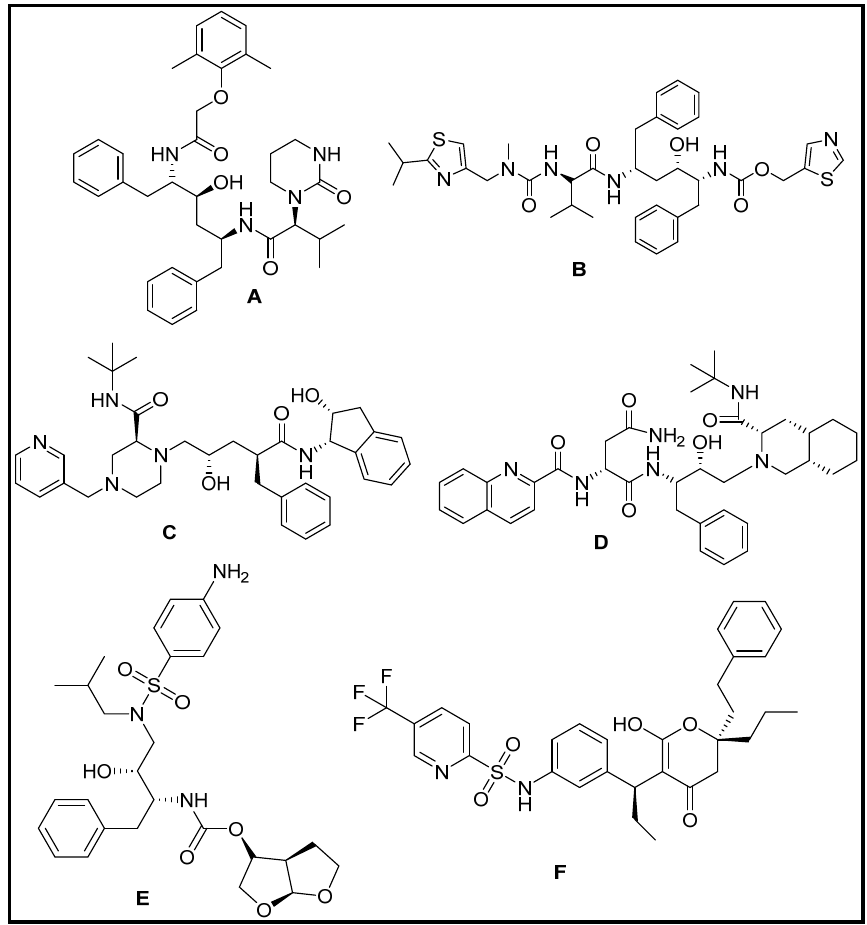
Figure 5. Chemical structures of six HIV protease inhibitors: ( A ) lopinavir; ( B ) ritonavir; ( C ) indinavir; ( D ) saquinavir; ( E ) darunavir; ( F ) tipranavir. A molecular dynamics study indicated three distinct domains for both 3CLpro-1 and 3CLpro-2 (Figure 6); however, molecular docking results showed that the 3CLpro of SARS CoV2 (PDB ID: 6LU7) for all studied drugs had higher binding affinities compared to SARS CoV1 (PDB ID: 1UJ1) [57].